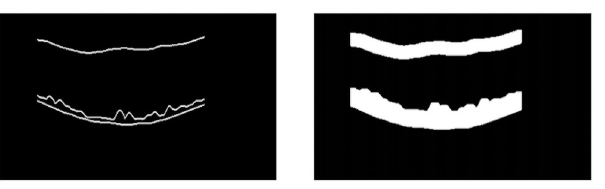
Fig 4. U-Net sample image. (a) Result of the ROI definition stage. (b) Image after dilation.